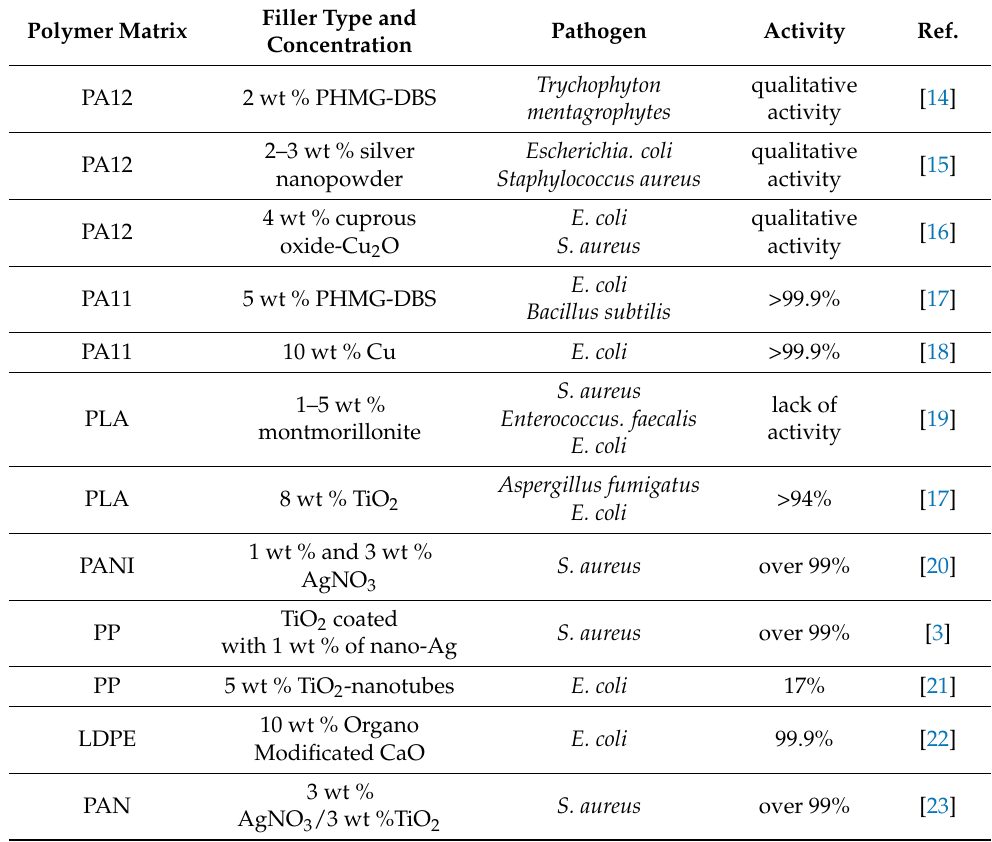
Table 1. The examples of antimicrobial thermoplastic composites described in the literature. Filler Type and Polymer Matrix